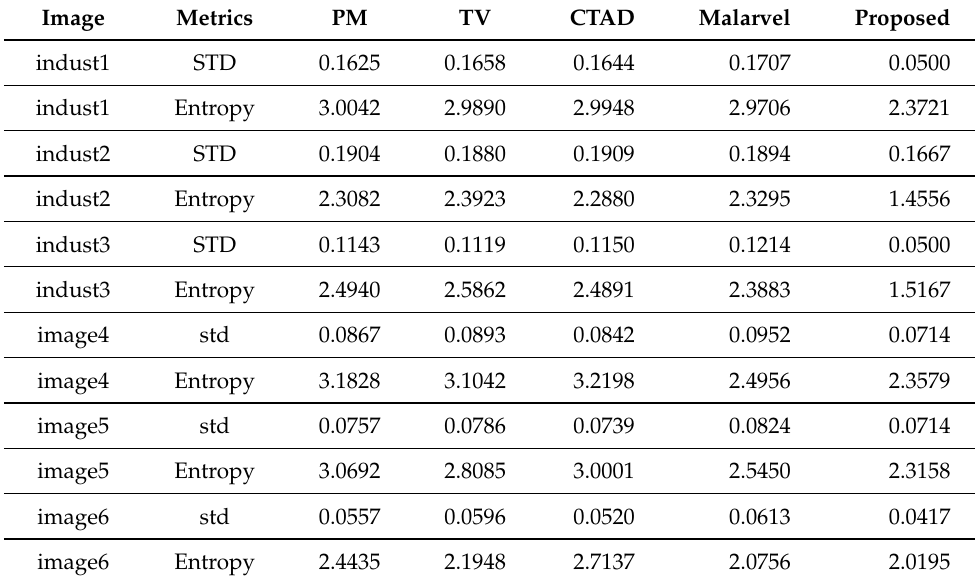
Table 7. Industrial image experiment results